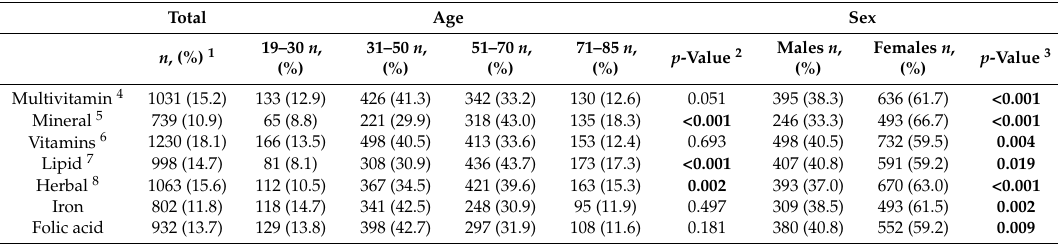
Table 4. Type of dietary supplements used by age and